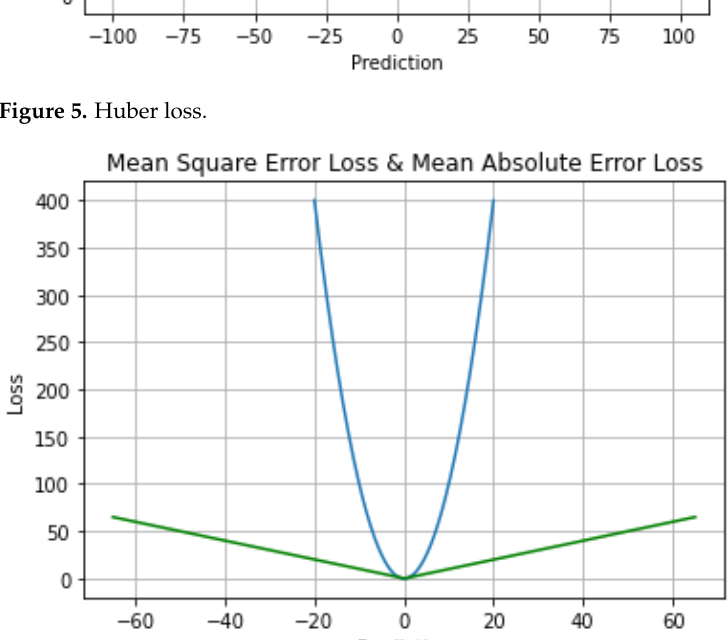
Figure 6. Mean Square Error loss & Mean Absolute Error loss.